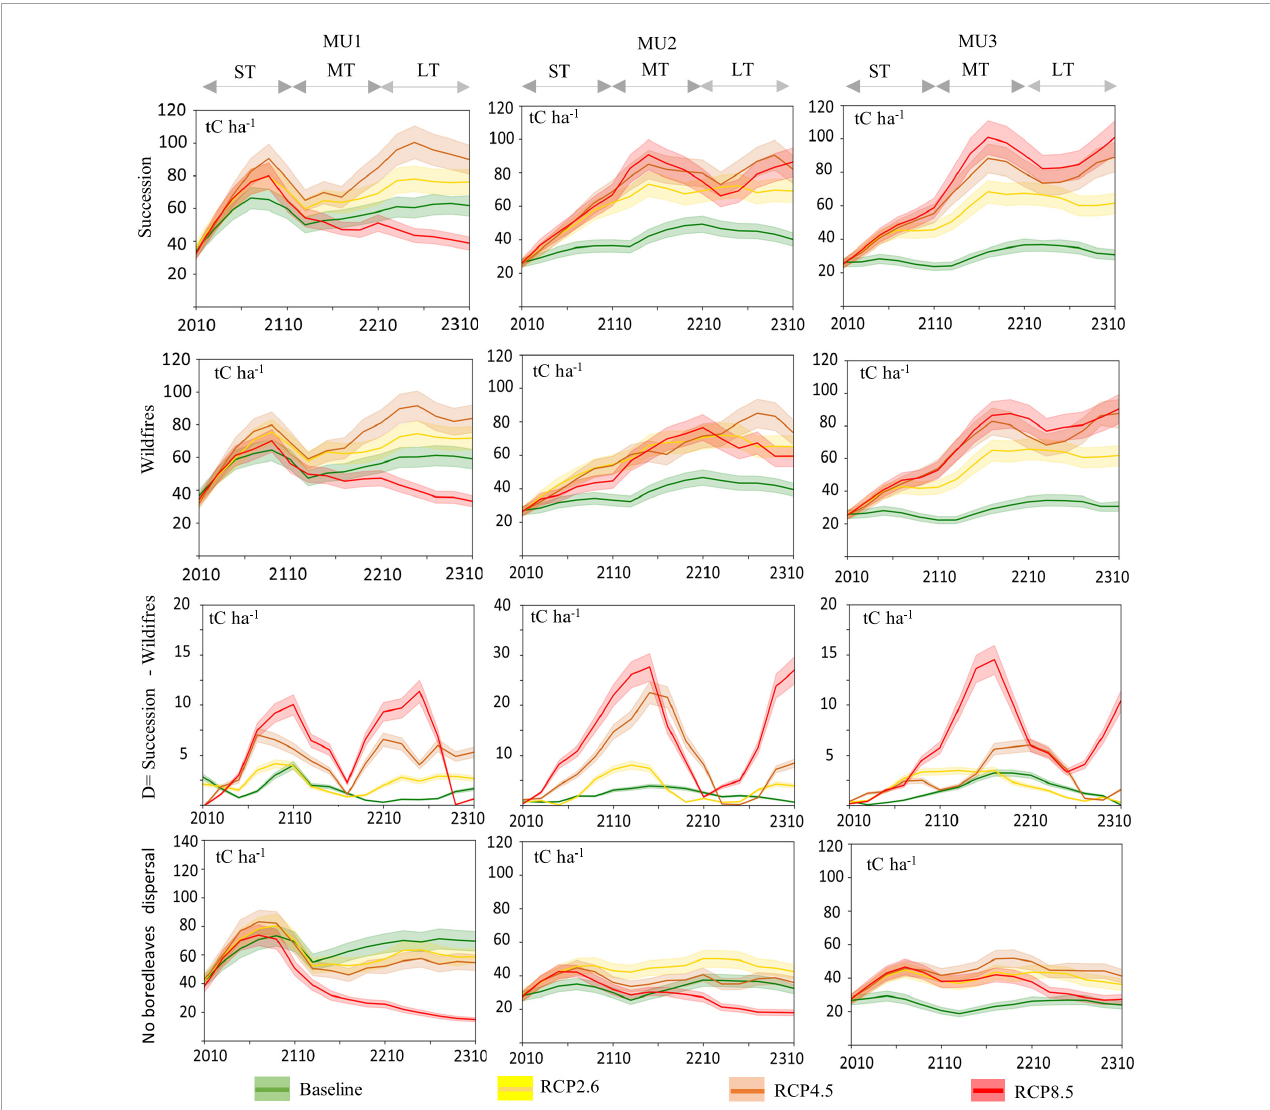
FIGURE6 Mean simulated annual total biomass (stem, roots) (tC ha - 1 ) projection for 300 years (2010–2310) under RCP and current climate (baseline) scenarios for three periods [(ST: 2010–2110); (MT: 2110–2210); (LT: 2210–2310)], with and without wildfires disturbance (see Figure 7 for more details per species). Difference (D) in carbon (C) loss due to wildfires integrated across the studied MU over time, relative to the no-disturbance scenario (only succession). The confident intervals were estimated from the three repetitions per time step to assess the stochastic effect of the model on the